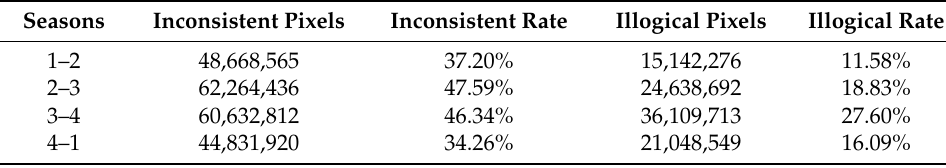
Table 8. Inconsistent pixel statistics by the modified